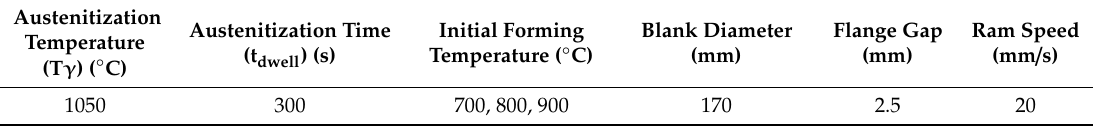
Table 2. Summarization of the thermomechanical process parameters used for the FE simulation of X12Cr13, X30Cr13 and